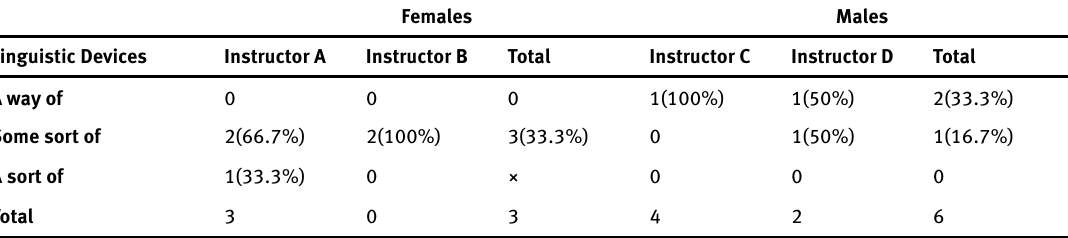
Table 8. Indefinite articles + nouns, numerals + nouns, general determiners +